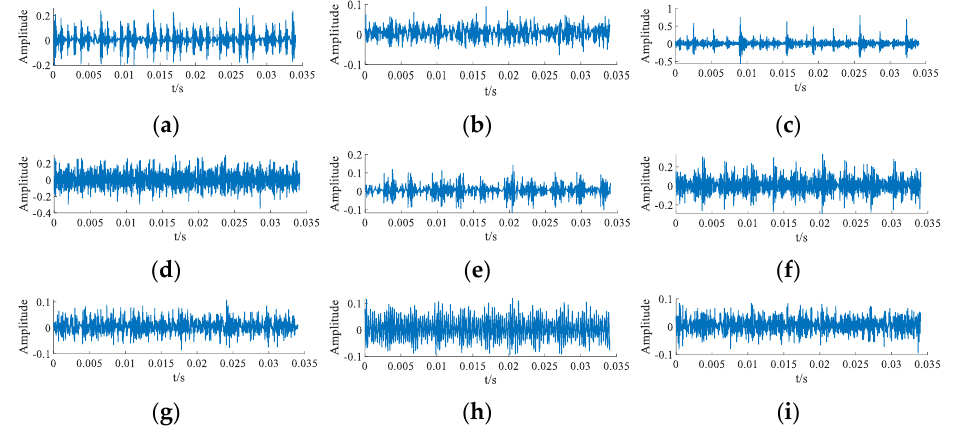
Figure 5. The denoised vibration signal of rolling bearings: ( a ) The denoised vibration signal of OR_07. ( b ) The denoised vibration signal of OR_14. ( c ) The denoised vibration signal of OR_21. ( d ) The denoised vibration signal of IR_07. ( e ) The denoised vibration signal of IR_14. ( f ) The denoised vibration signal of IR_21. ( g ) The denoised vibration signal of B_07. ( h ) The denoised vibration signal of B_14. ( i ) The denoised vibration signal of B_21.